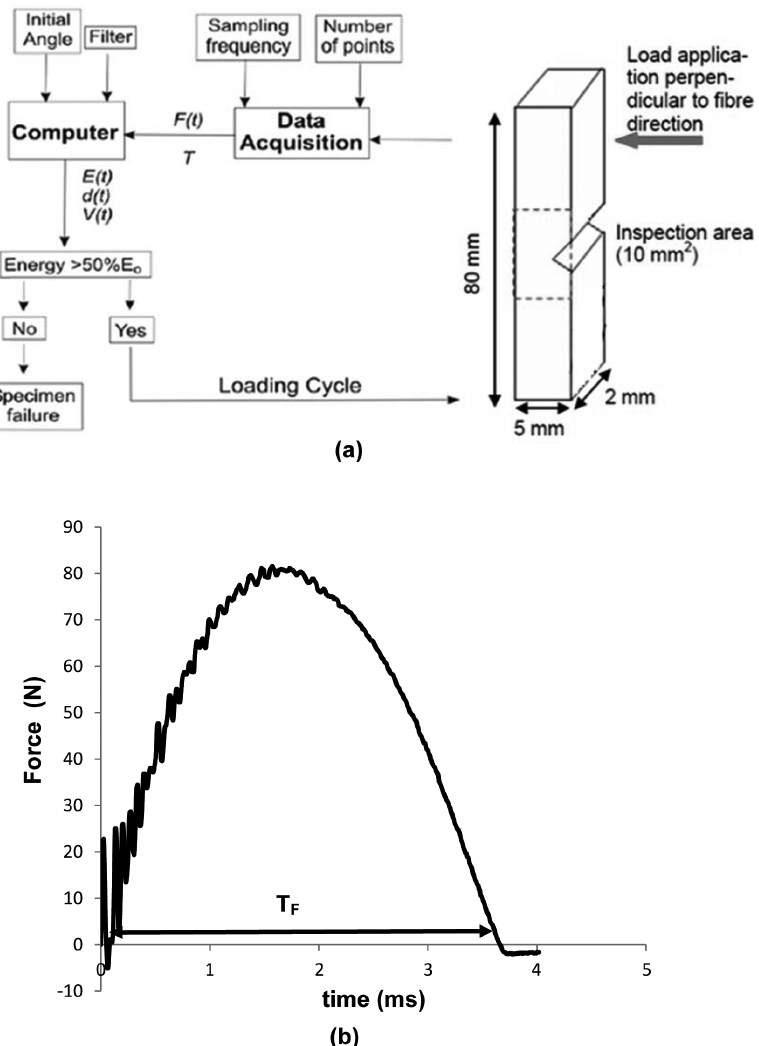
Fig. 3. (a) Izod test specimen during testing at energy of 0.02J and (b) force data acquisition indicating the loading time T F